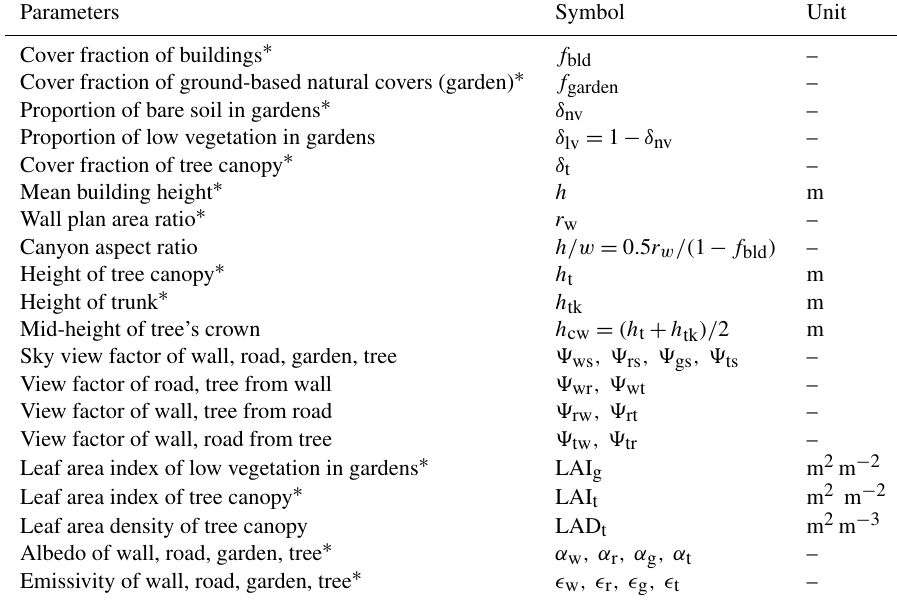
Table 1. Main descriptive parameters of the urban canyon, including vegetation, in the TEB model. The parameters followed by an asterisk are the input data prescribed by user, the other ones are computed in the model using the input parameters. Parameters Symbol Unit Cover fraction of buildings ∗ Cover fraction of ground-based natural covers (garden)